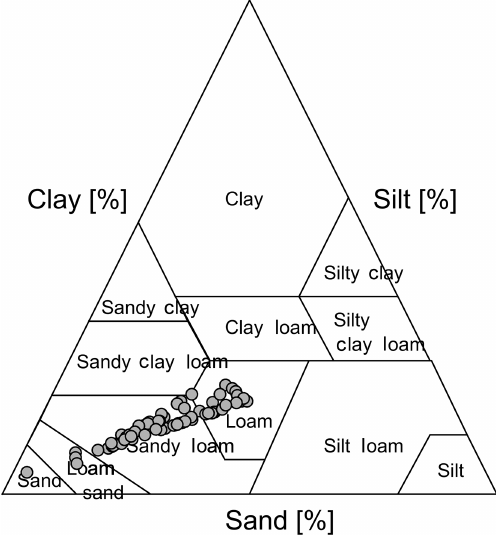
Figure 2. The area-weighted soil texture of all fields plotted on the USDA soil texture triangle, falling primarily in the sandy loam and loam textures. Data downloaded from the NRCS Web Soil